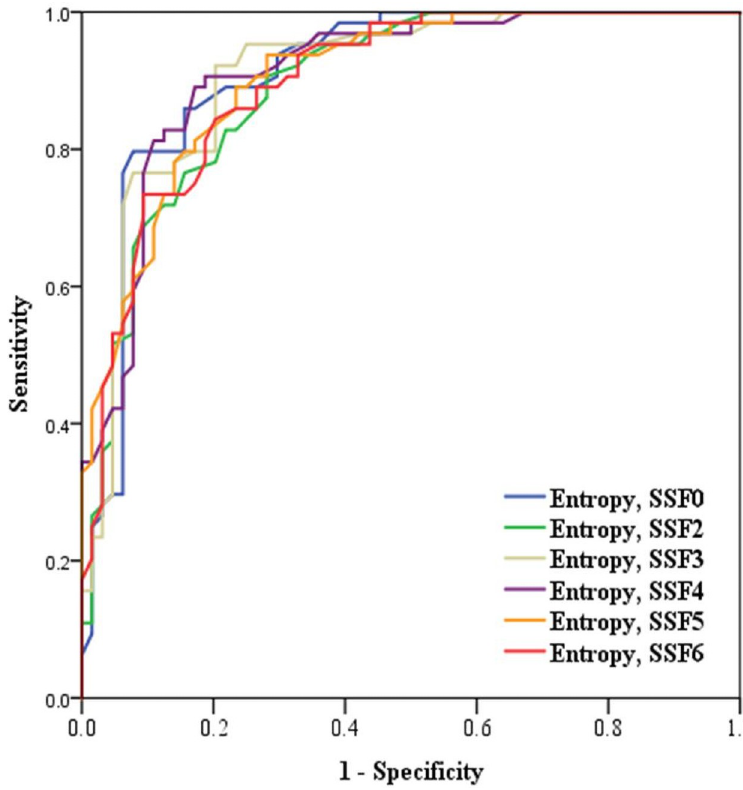
Fig 3. The ROC curve analysis was performed to differentiate tonsil cancer from normal tonsils. The AUC for entropy with SSF 0 and 4 was the highest at 0.91.